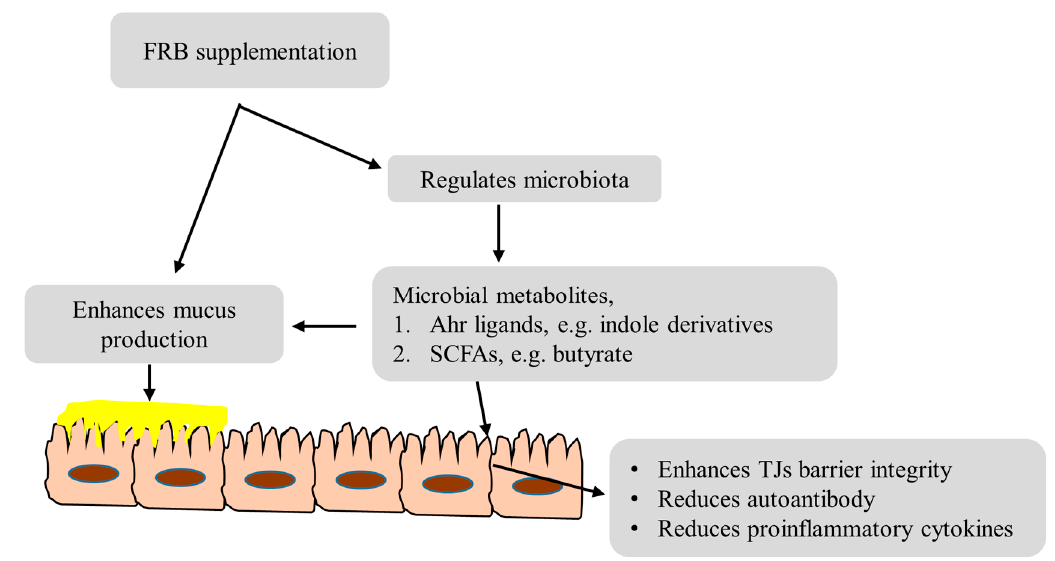
Figure 6. Prominent examples of FRB contributing to protect from DSS-induced colitis.